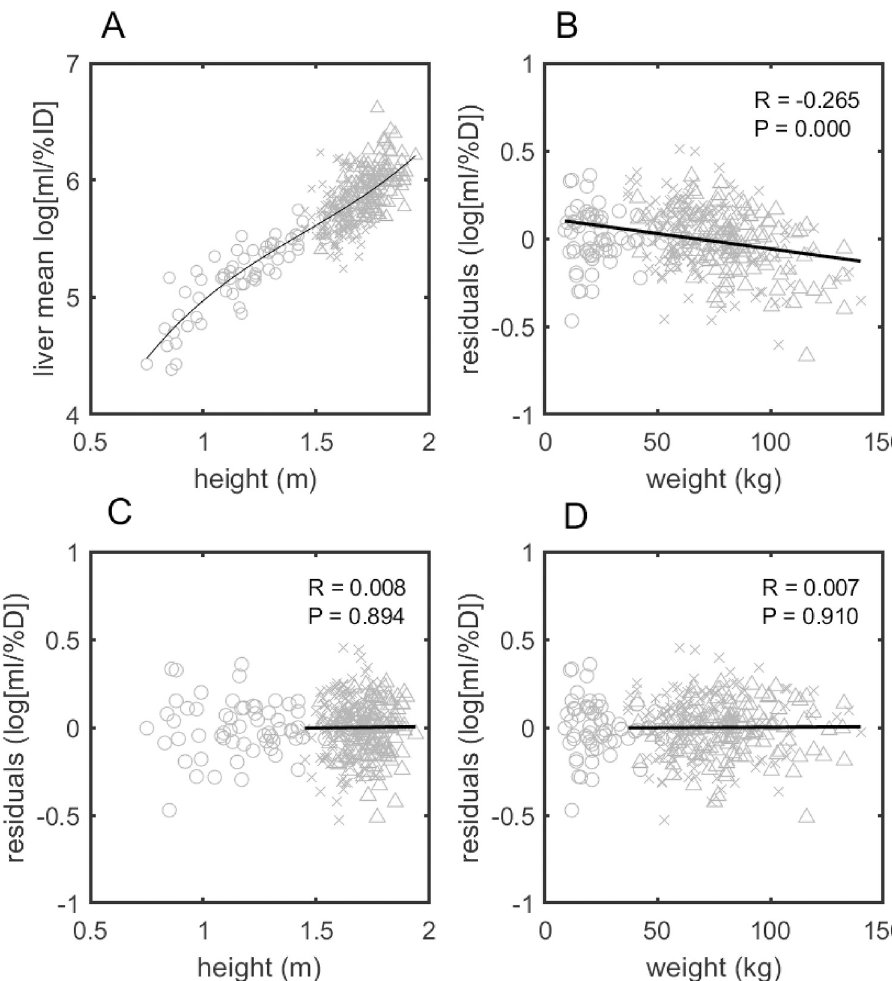
Fig 1. Training data, liver mean fits and residuals as a function of height and weight. Scatter plots showing the fit of the training set data to a third-order polynomial function of height (A), the residuals of that fit as a function of weight (B), the residuals of the model A fit to the log of the mean liver ml/%ID as a function of height (C) and its residuals as a function of weight (D). In all graphs, triangles depict male patients, x’s refer to female patients and o’s are children under the age of 12. The fits of the residuals shown in (C) and (D) along with the associated correlation coefficients and P values shown in the legend, excluded patients under the age of 12 so that these patients wouldn’t have outsized influence over the correlation. For Model A, regardless of whether the pediatric patients were included or not, there was no significant correlation of the residuals to either height or weight.